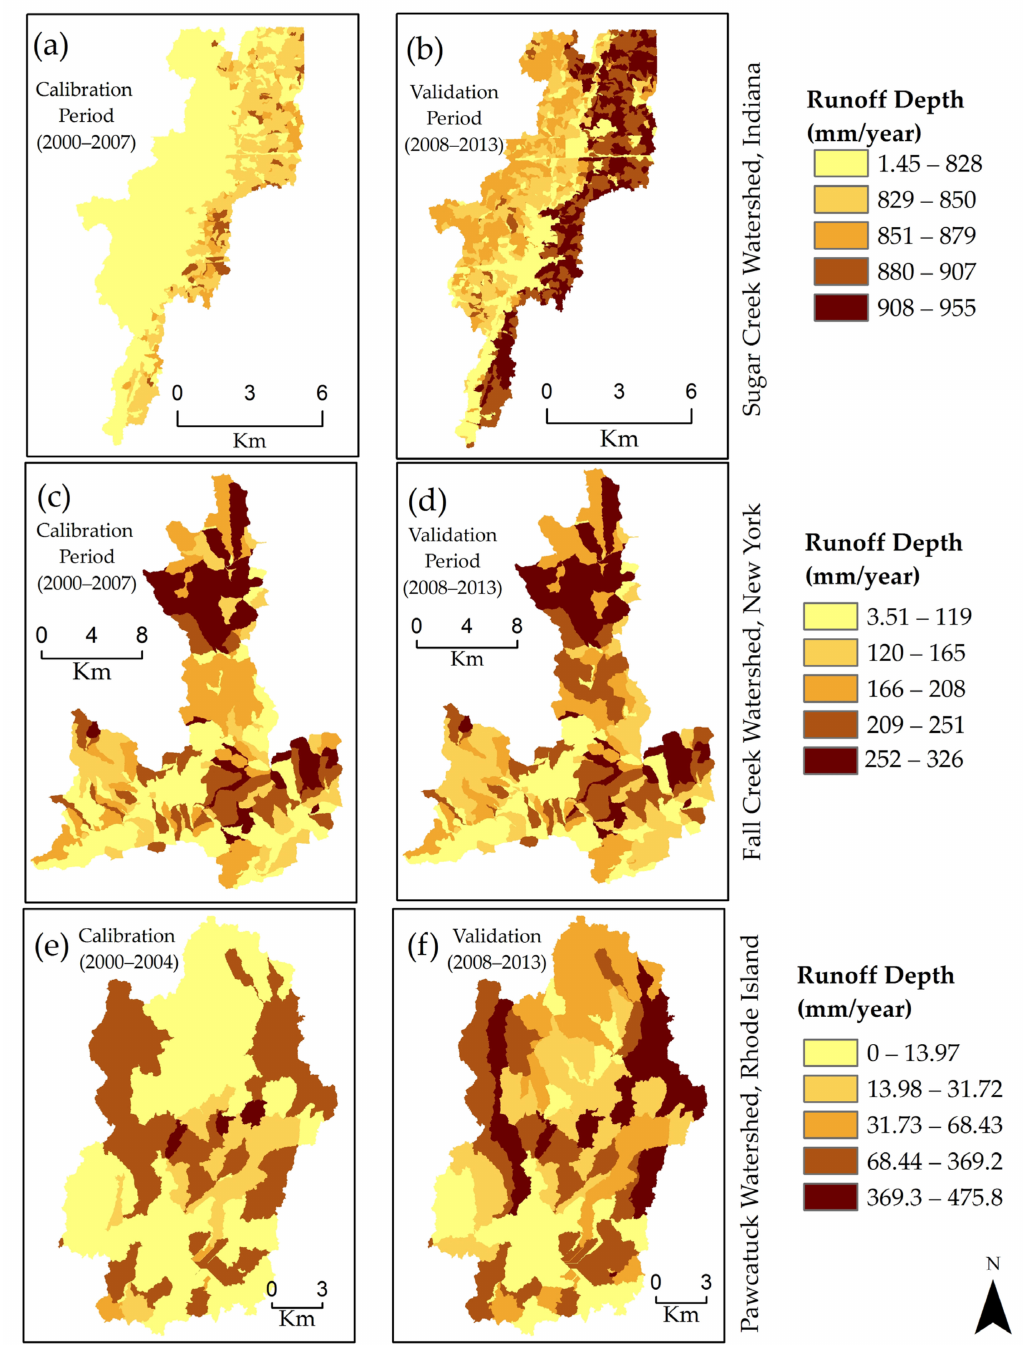
Figure 8. Spatial distribution of average annual runo ff depth in mm / year for: ( a ) calibration period, Sugar Creek Watershed; ( b ) validation period, Sugar Creek Watershed; ( c ) calibration period, Fall Creek Watershed; ( d ) validation period, Fall Creek Watershed; ( e ) calibration period, Pawcatuck River Watershed; ( f ) validation period, Pawcatuck River